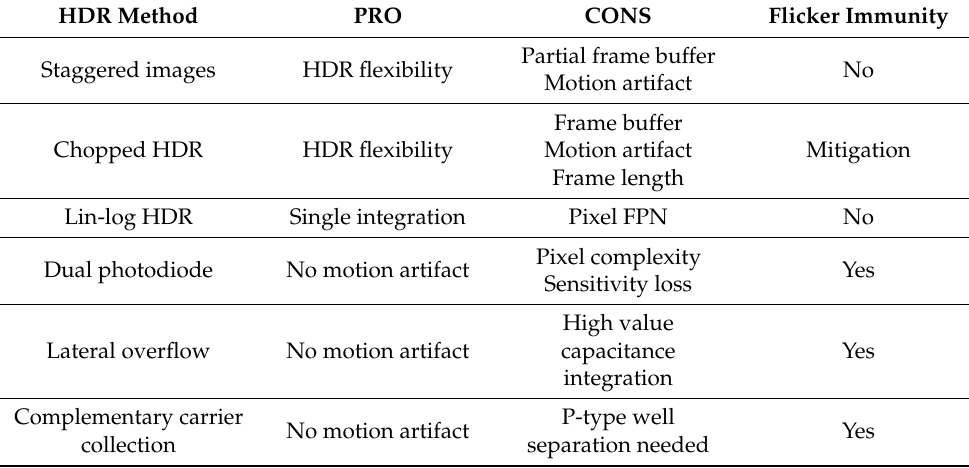
Table 1. High dynamic range (HDR) approach comparison.